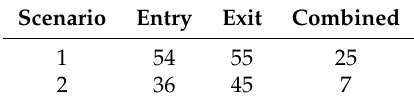
Table 5. Main-flow key data for both scenarios (reduced main-flow network).